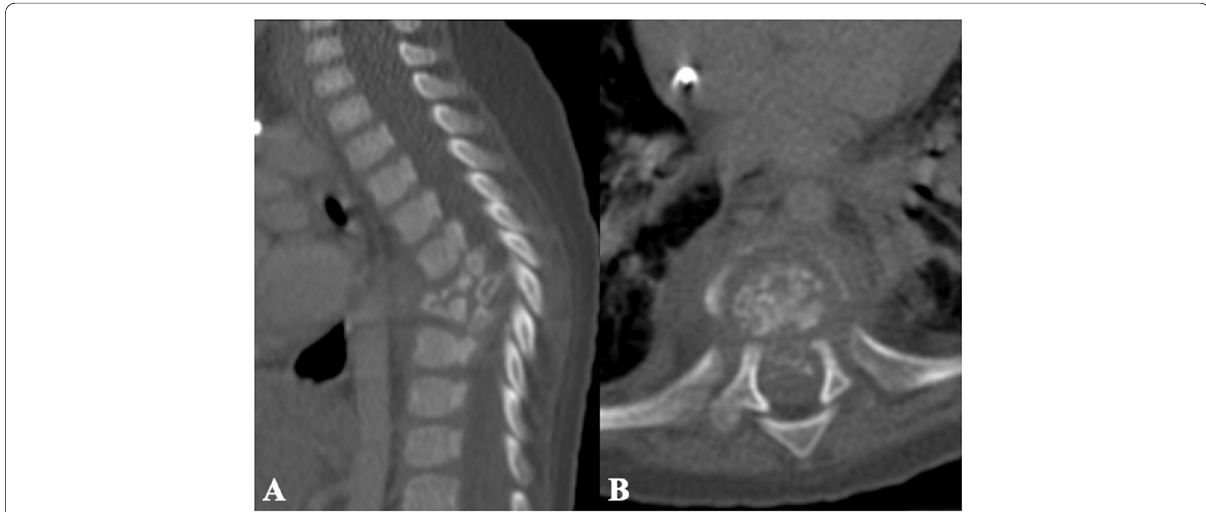
Fig. 2 Dorsal CT scan in bone window, the vertebral destruction of D7 and D8 is observed in A sagittal view and B axial view